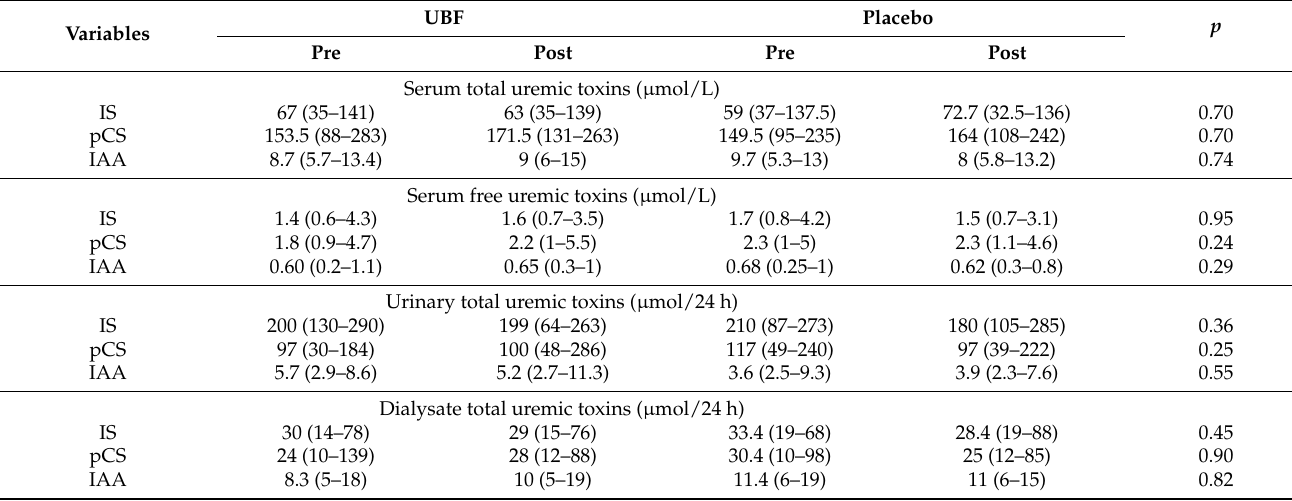
Table 3. Uremic toxins according to UBF and placebo arms during the follow-up of patients undergoing peritoneal dialysis ( n =